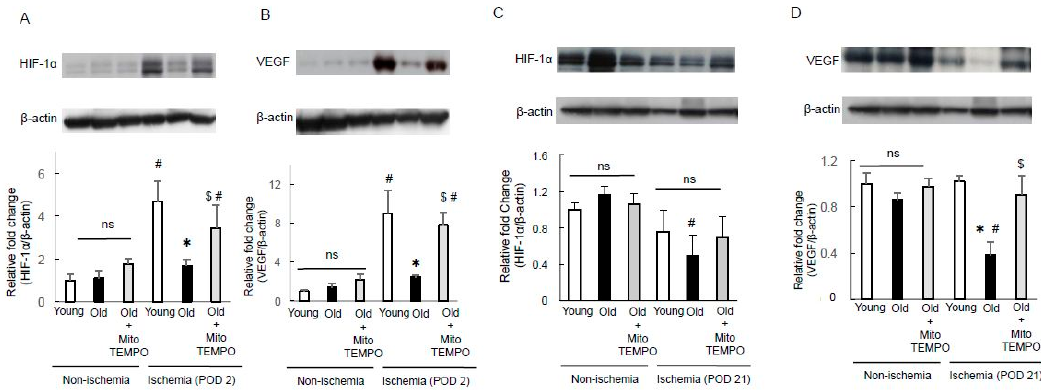
Figure 5. The protein expression of hypoxia-inducible factor-1 α (HIF-1 α ) and vascular endothelial growth factor (VEGF). The expression of HIF-1 α and VEGF were analyzed by Western blotting in the non-ischemic and ischemic (POD 2 and 21) skeletal muscles of young, old, and MitoTEMPO-treated old mice. Representative images of HIF-1 α (( A , C ) POD 2, 21, respectively) and VEGF (( B , D ) POD 2, 21, respectively) and summarized findings after quantification of HIF-1 α / β -actin and VEGF/ β -actin. For POD 2, both HIF-1 α and VEGF expression during ischemia were higher in young mice than in non-ischemic mice, but not in old mice. MitoTEMPO treatment upregulated HIF-1 α and VEGF expression in the skeletal muscle of old mice. For POD 21, neither HIF-1 α nor VEGF expression under ischemia were elevated compared to non-ischemic mice. HIF-1 α expression did not differ among the three groups. The VEGF expression of aged skeletal muscle was lower than young muscle, and MitoTEMPO treatment preserved the expression of VEGF. The values are expressed as the means ± S.E.M. n = 10, each. * p < 0.05 vs. young mice, $ p < 0.05 vs. old mice, # p < 0.05 vs. non-ischemic skeletal muscle. ns indicates no significant difference.